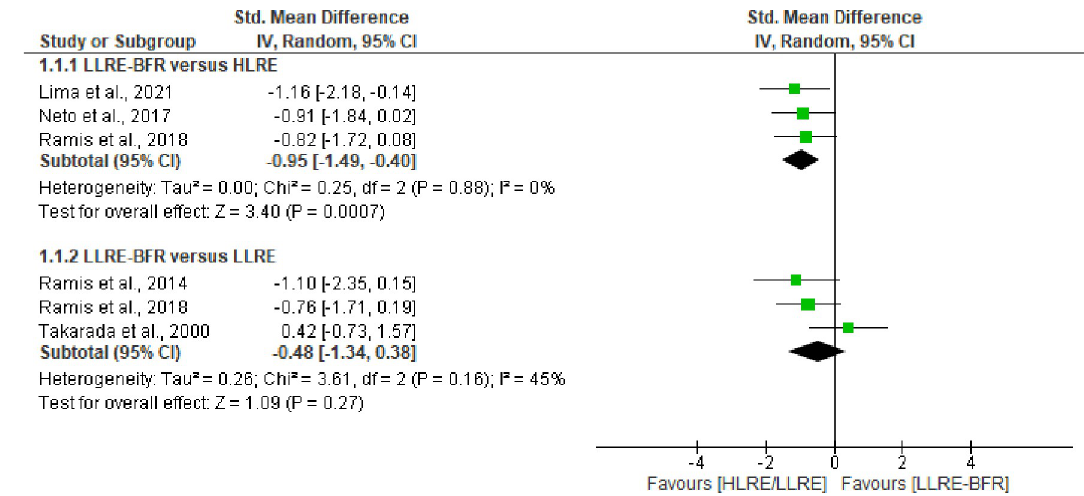
Fig 2. Forest plot about effects of LLRE-BFR versus HLRE and LLRE on biomarkers of damage to lipids post-exercise. LLRE-BFR: Low load resistance exercise with blood flow restriction; HLRE: High-load resistance exercise, LLRE: Low load resistance exercise; SMD: Standardized mean difference; SD: Standard deviation; IV: Inverse variance; CI: Confidence interval.